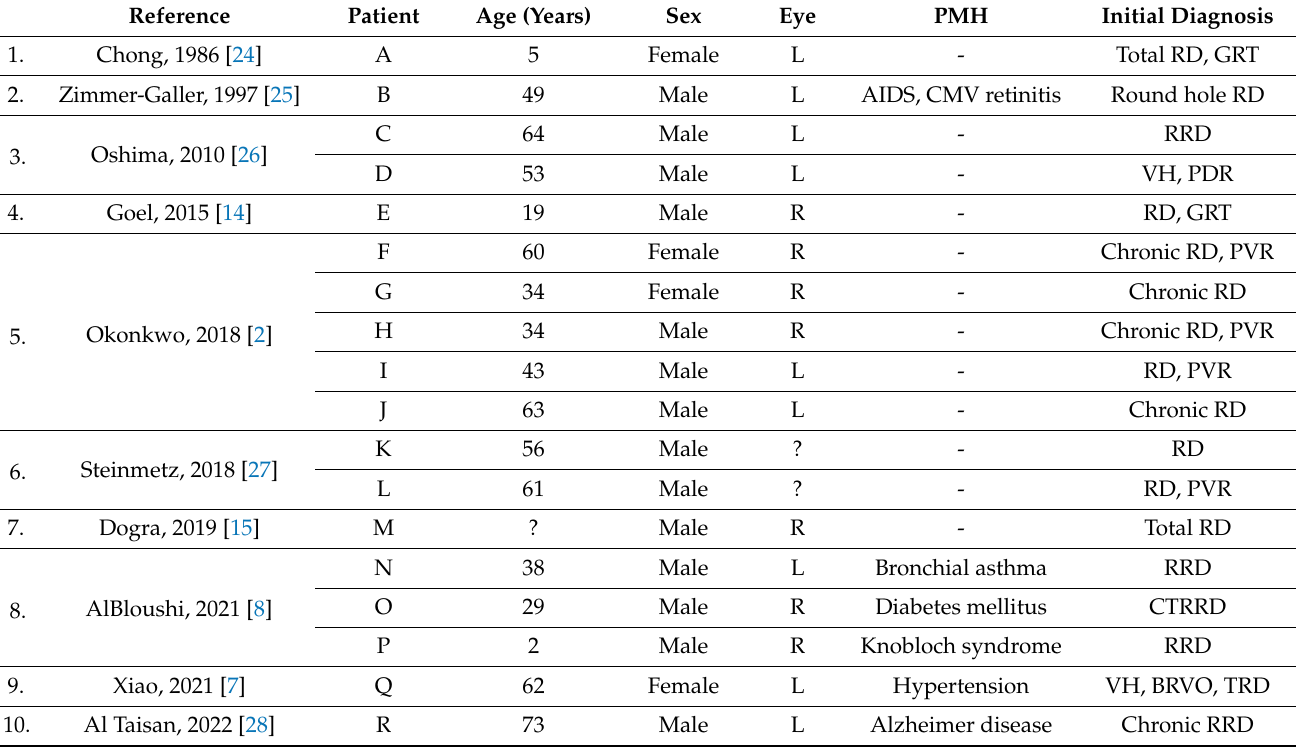
Table 1. Summary of patient characteristics from previous reports of endophthalmitis in silicone oil-filled